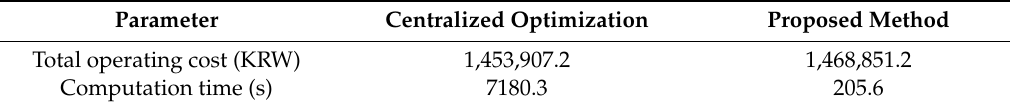
Table 4. Performance comparison of the two power sharing methods.